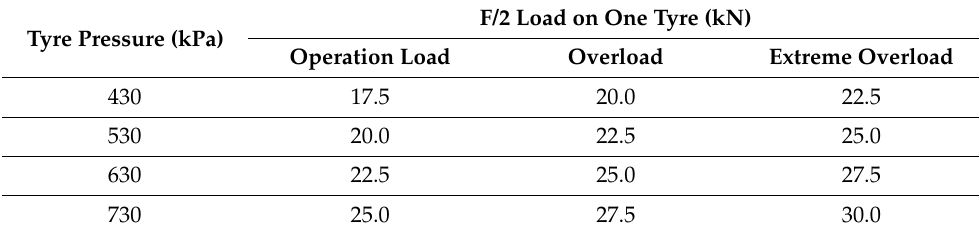
Table 6. The tyre–pavement interaction simulation matrix.